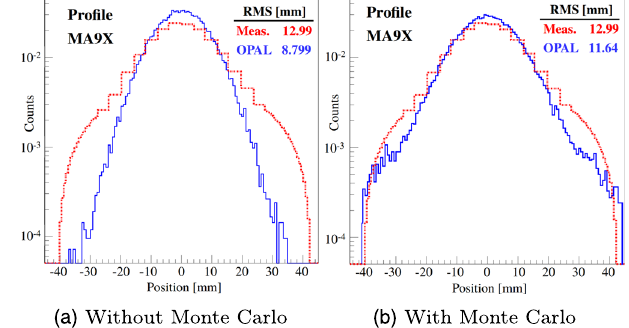
MA9X.FIG. 10. Comparison between the particle distribution from the OPAL model with the measured beam profiles from two selected monitors: MA25X placed after a collimator and MA19X placed in a free area away from a